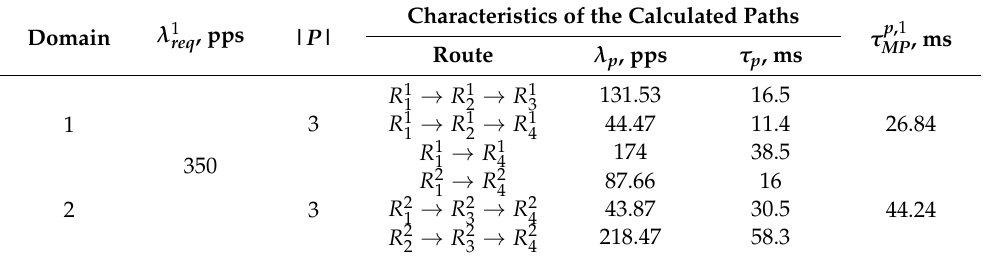
Table 4. Characteristics of the calculated routes in Figure 7.